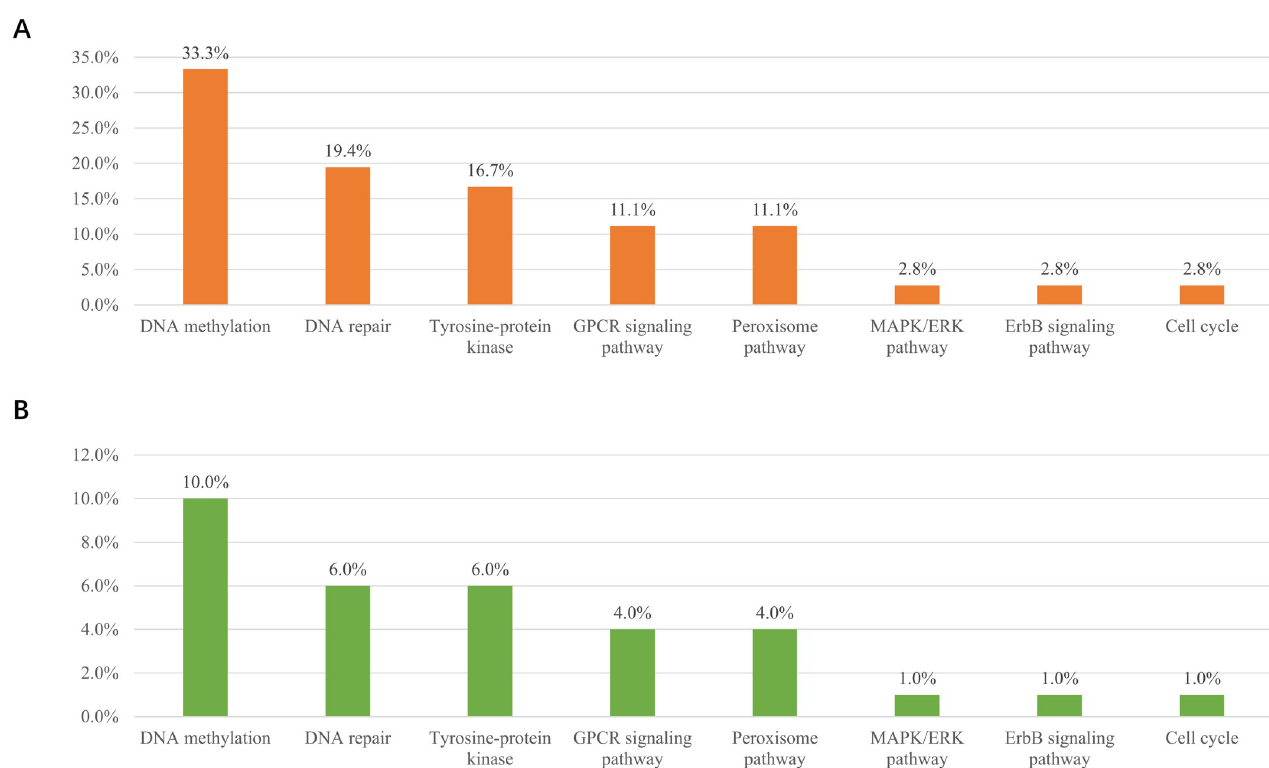
Fig 4. Categorization of germline mutations among (A) 36 deleterious variants and (B) the patient cohort (N = 100). The pathways are ordered by frequency.